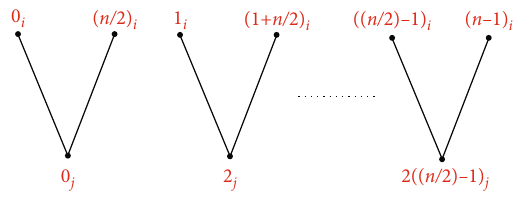
Figure 6: The labelling for ðð n /2 Þ K